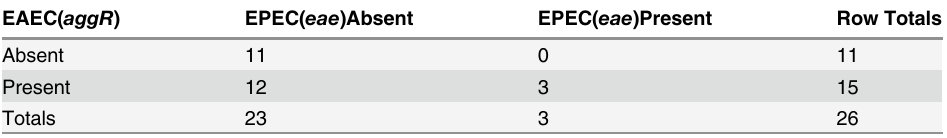
Table 3. Comparison for the detection of eae and aggR genes in the Berg and Plankenburg River systems using the real-time multiplex PCR. EAEC( aggR ) EPEC( eae )Absent EPEC( eae )Present Row Totals Absent Present Totals 23 26 P value = 0 . 0015